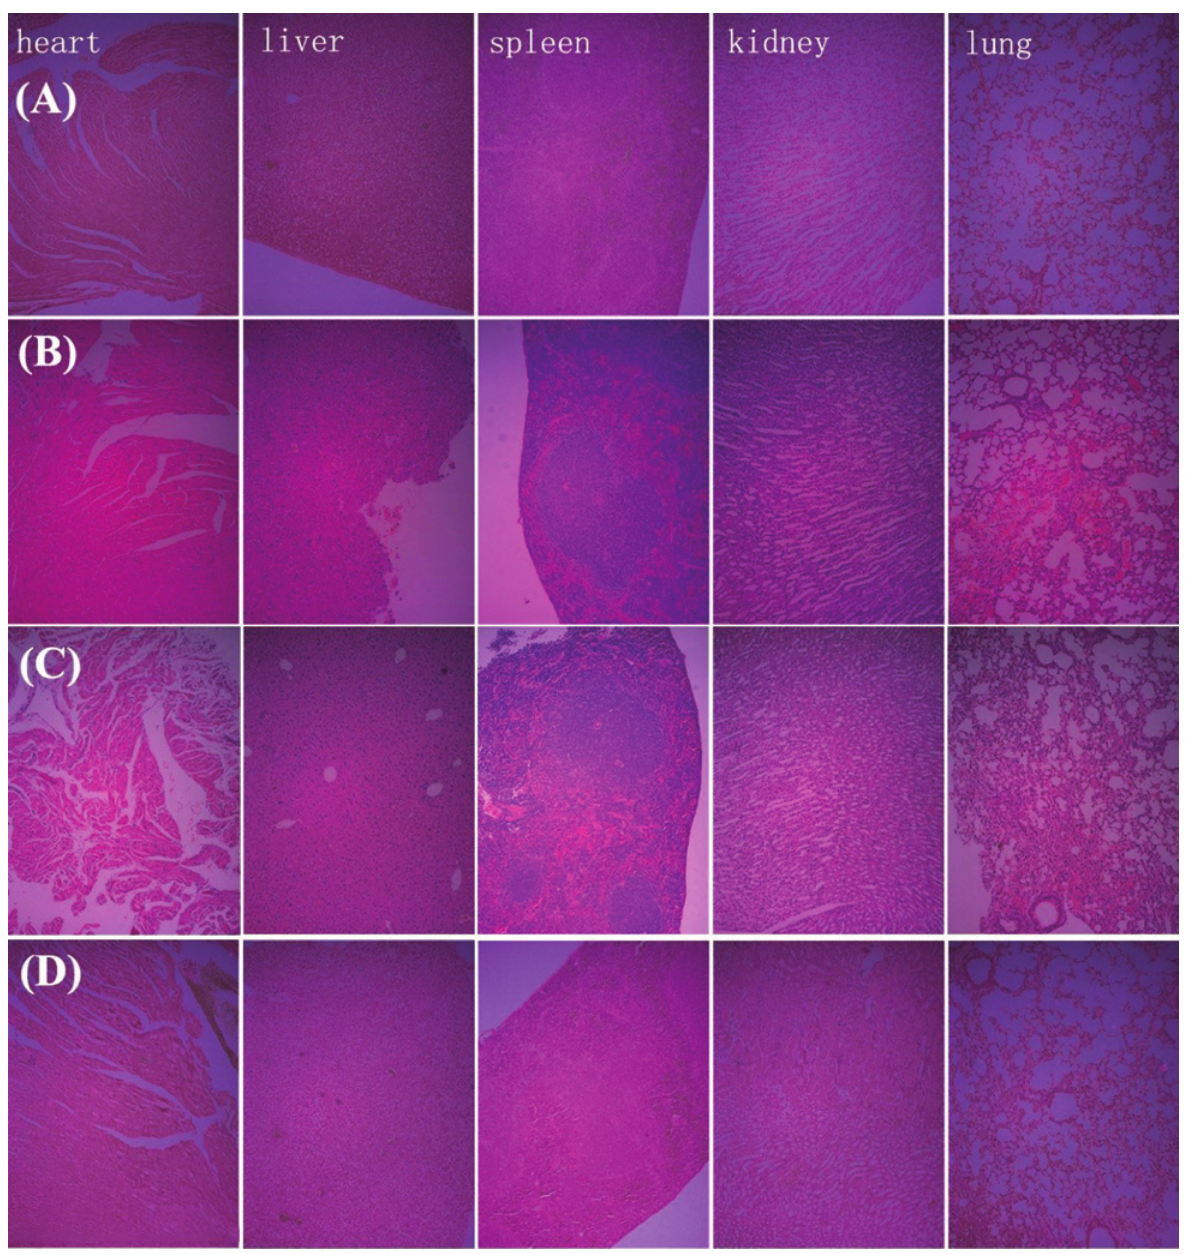
Figure 5: Microscopy images of H&E stained tissue slices (heart, liver, spleen, kidney, and lung) of (A) MTX/CMC-GO, (B) CMC-GO, (C) MTX injected mice and (D) blank control group. (Magnification = 400 ×